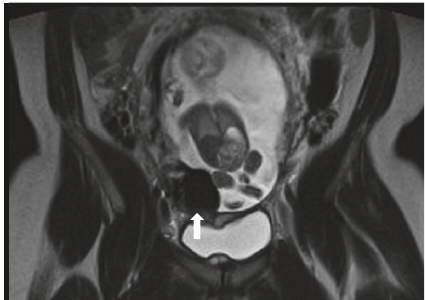
Figure 2: Coronal T2-weighted image of the pelvis at 18 weeks of gestation demonstrates a hypointense round structure (arrow) at the lower uterine segment infringing upon (and invaginating into) the gestational cavity. Fetal knee abuts and deforms the lesion.